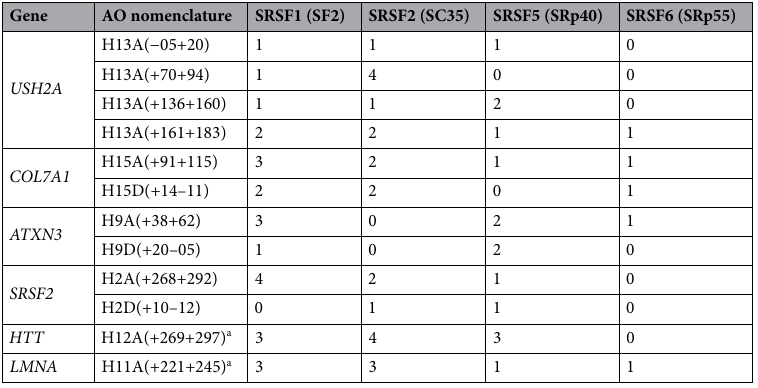
Table 2. Exonic splicing enhancer motifs masked by the antisense oligonucleotides examined in this study. a Not tested in this study; published